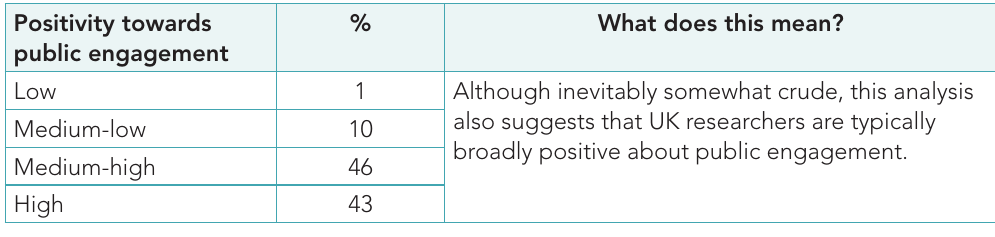
Table 5: Extent of positive views towards public engagement Positivity